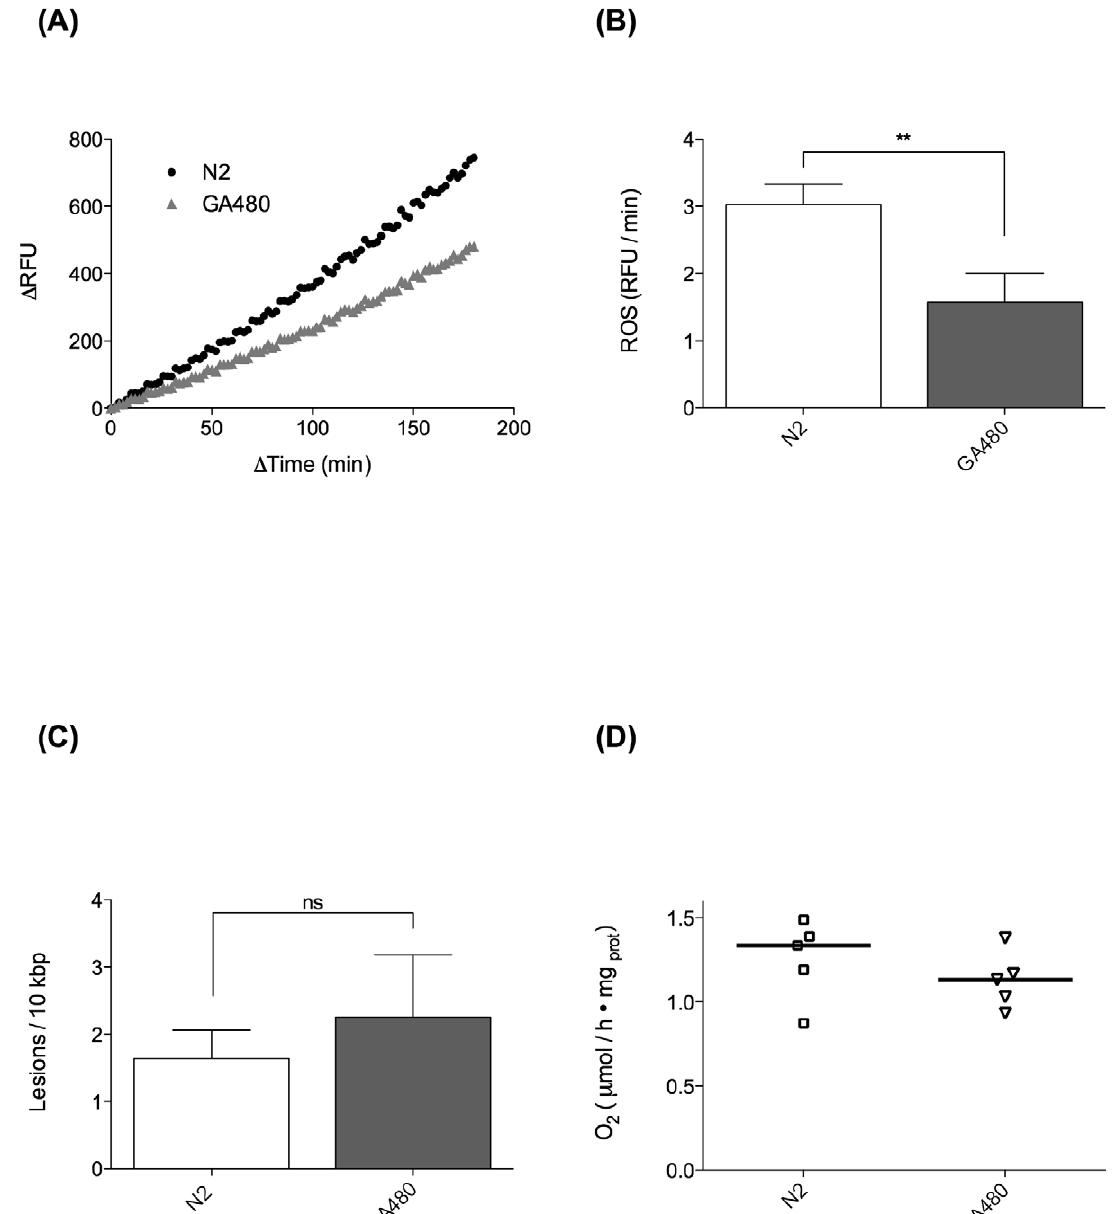
Figure 6. MnSOD mutants do not suffer from elevated oxidative damage. Comparison of ROS related parameters between MnSOD double mutant strain GA480 and WT N2 C. elegans . ( A ) Averaged fluorescence signal from whole worm DCF-DA generalised ROS assay (n=7 repeats) of day 4 WT and GA480 animals. Despite lacking both forms of mitochondrial SOD, GA480 animals produce less ROS associated fluorescence signal than WT animals. ( B ) Analysis of the data from (A); GA480 produce statistically significantly less ROS as measured by our DCF-DA assay (P=0.024, Student’s t- test). ( C ) Oxidative mtDNA lesions in mtDNA samples (n=4, each) of day 4 GA480 and WT worms. GA480 does not suffer from significantly elevated oxidative damage as judged by our qRT-PCR assay for oxidative mtDNA damage (P=0.43, Student’s t-test). ( D ) Oxygen consumption in GA480 vs. WT animals on day 4 of life. The median oxygen consumption was not significantly different between GA480 and WT (P=0.31, Mann-Whitney test).